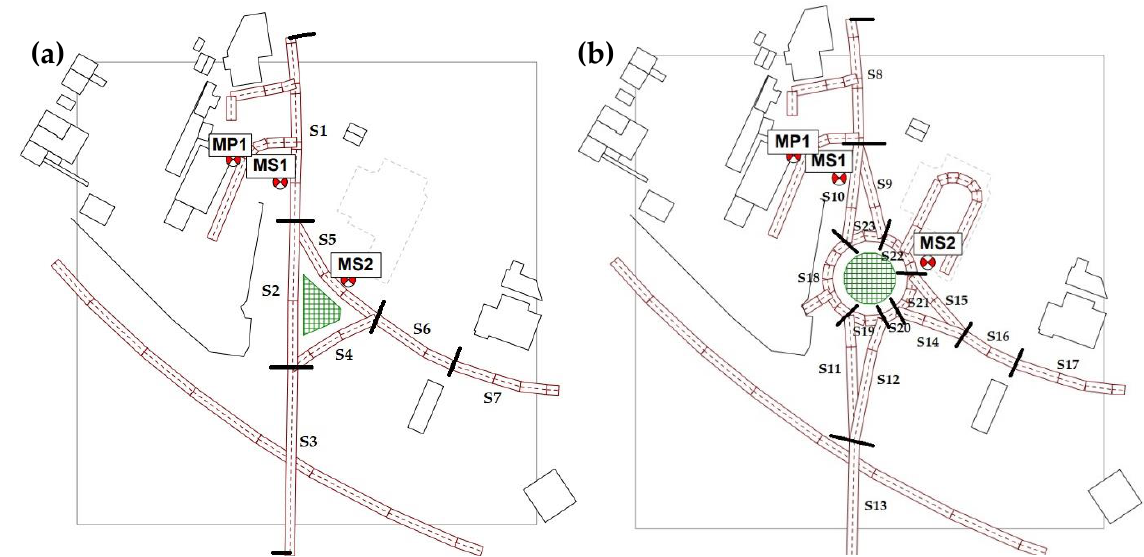
Figure 8. Distribution of homogeneous intersection sections ( a ) three-arm intersection-T_16, ( b ) roundabout- R_17, R_22) in the city of Žilina .